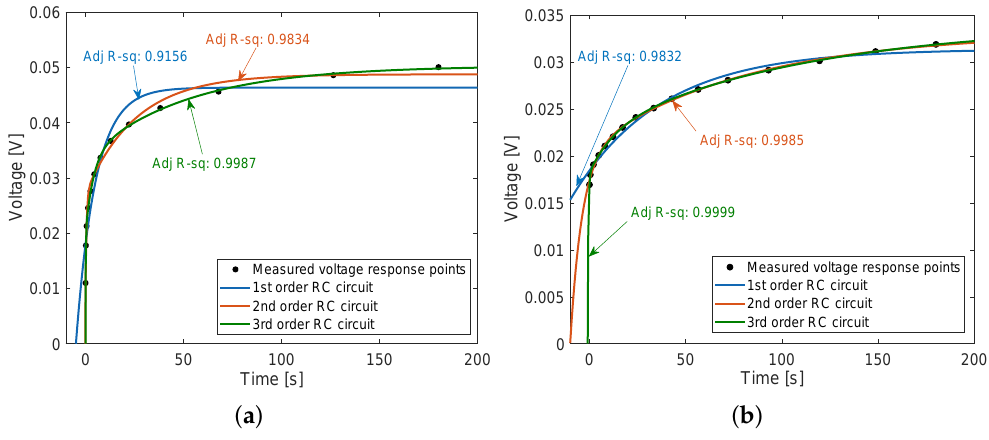
Figure 7. Comparison of accuracy with modelling battery into different orders of RC circuits: ( a ) VRLA battery; ( b ) LFP